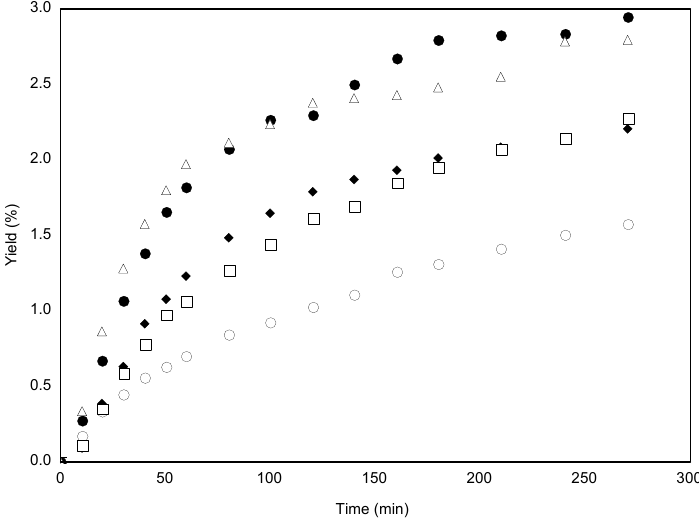
Figure 2. Supercritical fluid extraction curves of Calophyllum brasiliense leaves by mesh 50. ( ○ ) P = 10.92 MPa, T = 313 K, ρ = 0.6813 g/mL; ( ♦ ) P = 15.00MPa, T = 313 K, ρ = 0.7811 g/mL; ( □ ) P =17.67 MPa, T = 333 K, ρ = 0.6813 g/mL; ( ● ) P = 24.41 MPa, T = 333 K, ρ = 0.7811 g/mL; ( ∆ ) P = 25.00MPa, T = 313 k, ρ = 0.8802